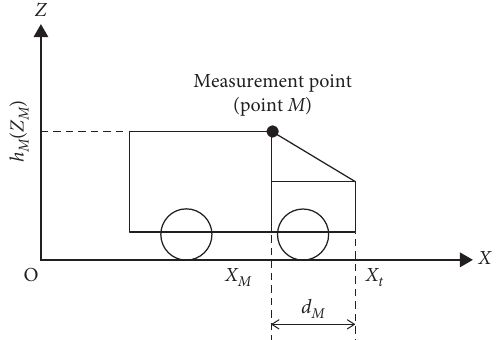
Figure 3: Some recommended measurement points. M upper edge of vehicle, M 2 : front upper edge of vehicle or upper edge of windscreen (these two points are nearly identical in most types of vehicles), M 3 : lower edge of windscreen, M 4 : upper edge of license plate, M 5 : lower edge of license plate, and M 6 : front lower edge of vehicle.